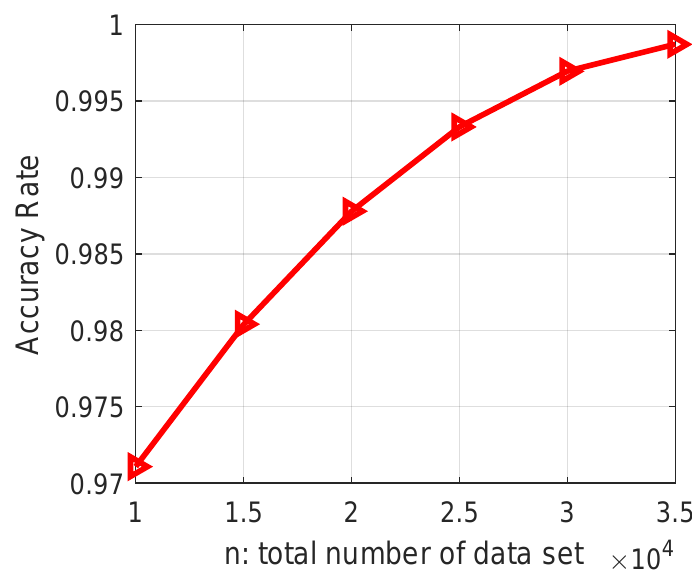
Figure 8. Accuracy rate of PPDC on different size of